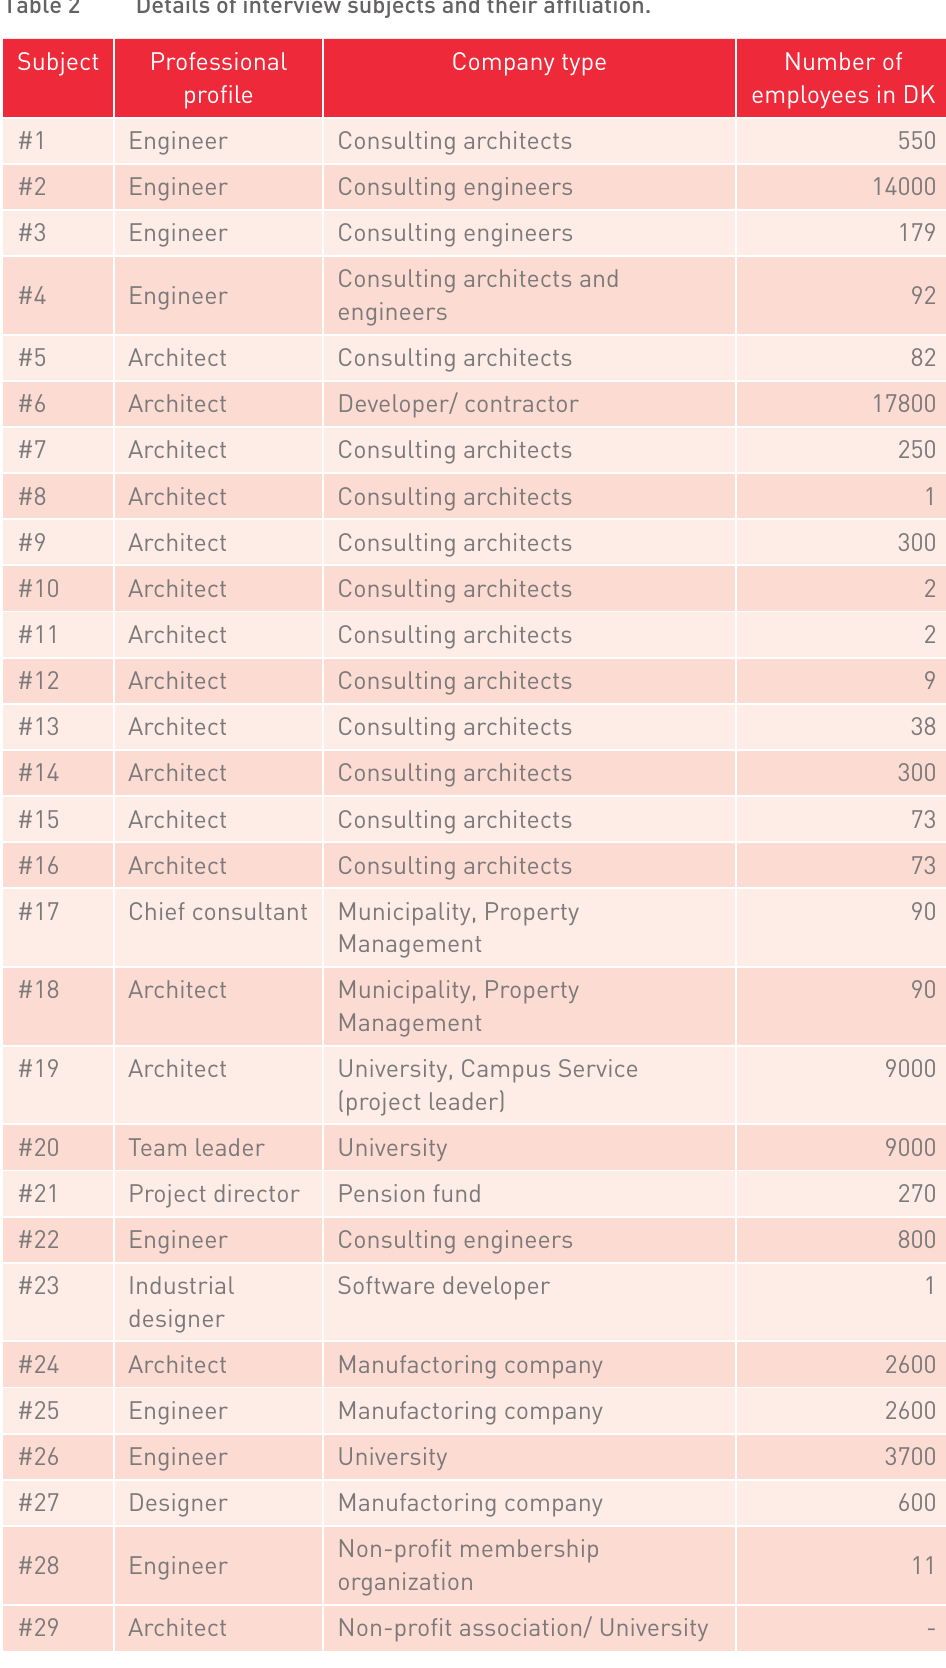
Table 2 Details of interview subjects and their